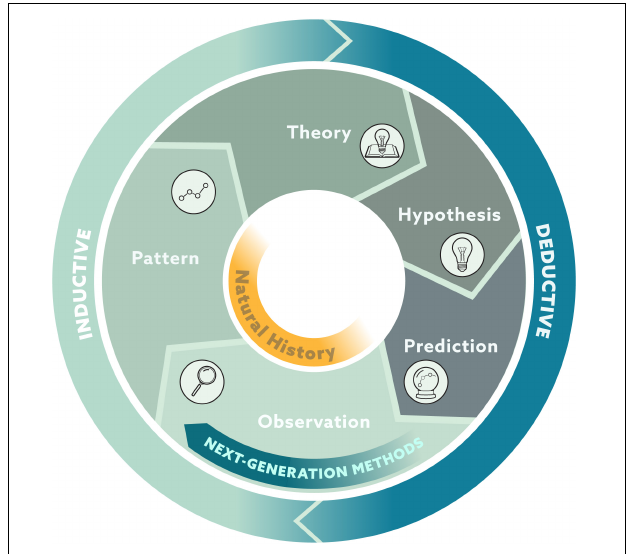
FIGURE 2 | Conceptual framework of the scientific method where observations both form the foundation of ecological theories through inductive reasoning and serve as the validation of ecological theories through deductive